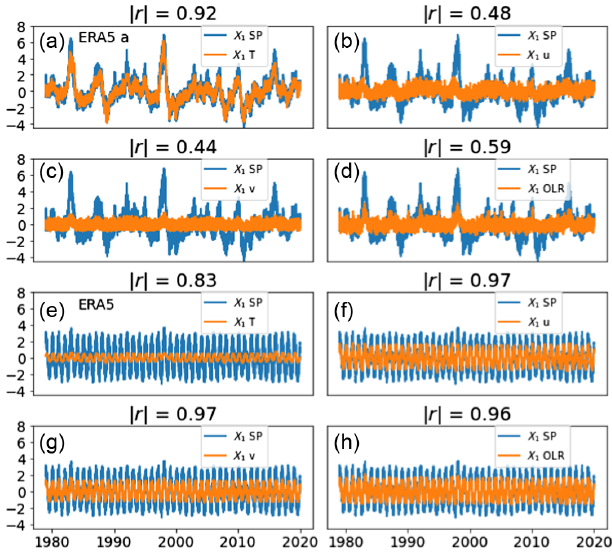
FIG. 3. First Isomap ( X 1 ) component for anomalies (panels a – d) and raw data (panels e – h) in ERA5. In each case components have been standardized so that the total variance is equal to 1. Projections in the multivariate case are shown in blue and labeled as “ SP ” (state space). Projections for each, univariate field are shown in red. Atop of each plot is the correlation coefficient (in absolute value) between the projections in the multivariate and univariate cases.